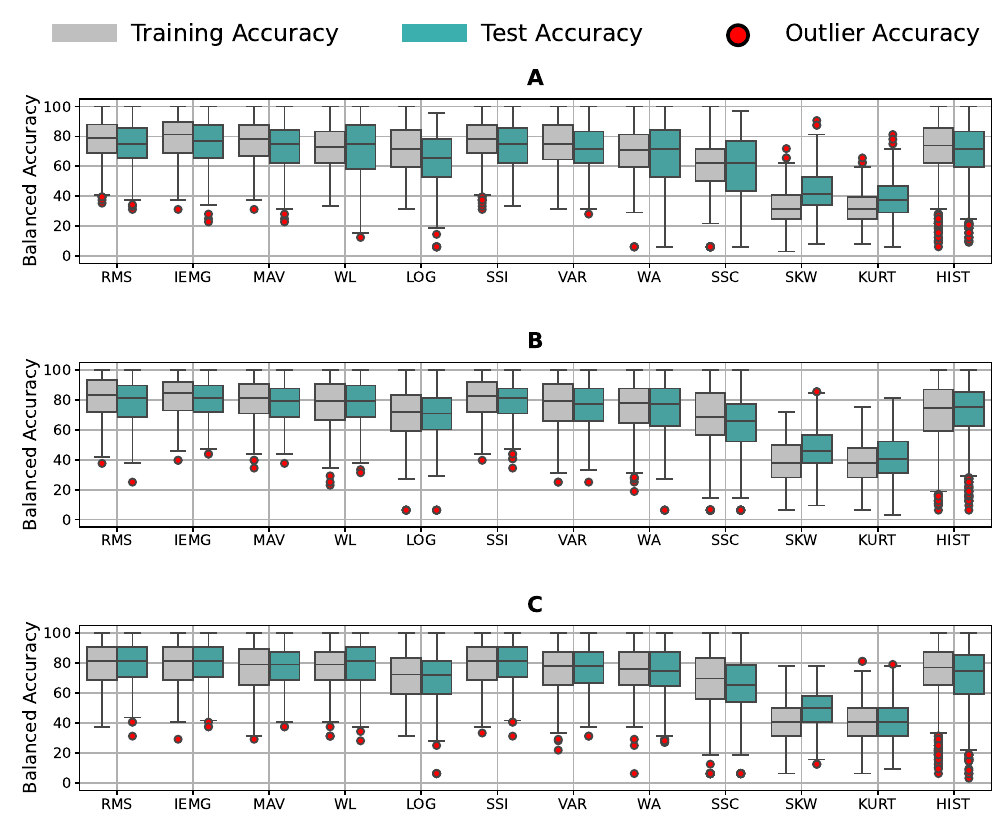
Figure 11. Accuracy distribution averaged over features for both sessions of ( A ) grasp gestures, ( B ) Sign Language gestures, and ( C ) unique movements gestures using all participants’